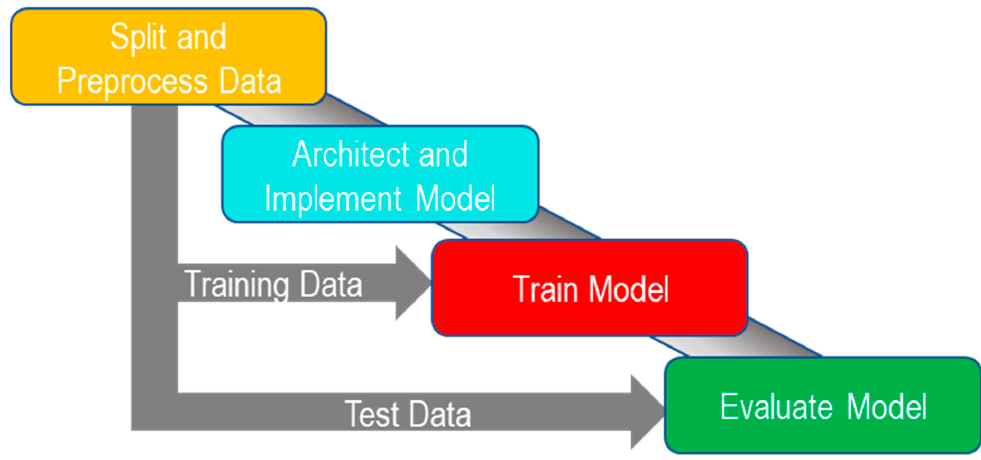
Figure 1. Steps used in the study.